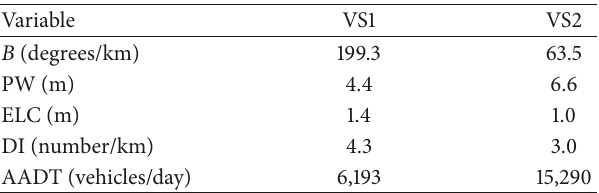
Figure 2: Comparison between the OSFM and a speed profile method. Table 3: Geometric and traffic characteristics of the validation segments.